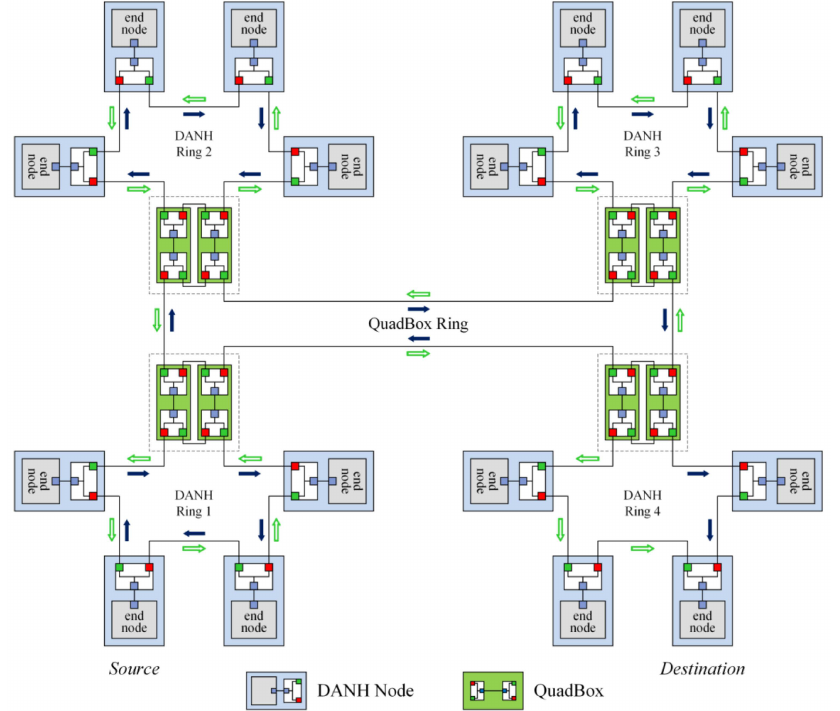
Figure 2. HSR example of the connected-ring topology for unicast